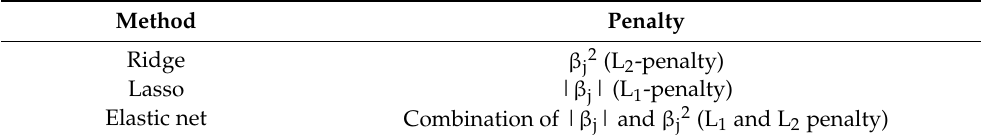
Table 2. Penalization regression methods and associated penalties. Method Penalty Ridge β j2 (L 2 -penalty) Lasso | β j | (L 1 -penalty) Elastic net Combination of | β j | and β j2 (L 1 and L 2